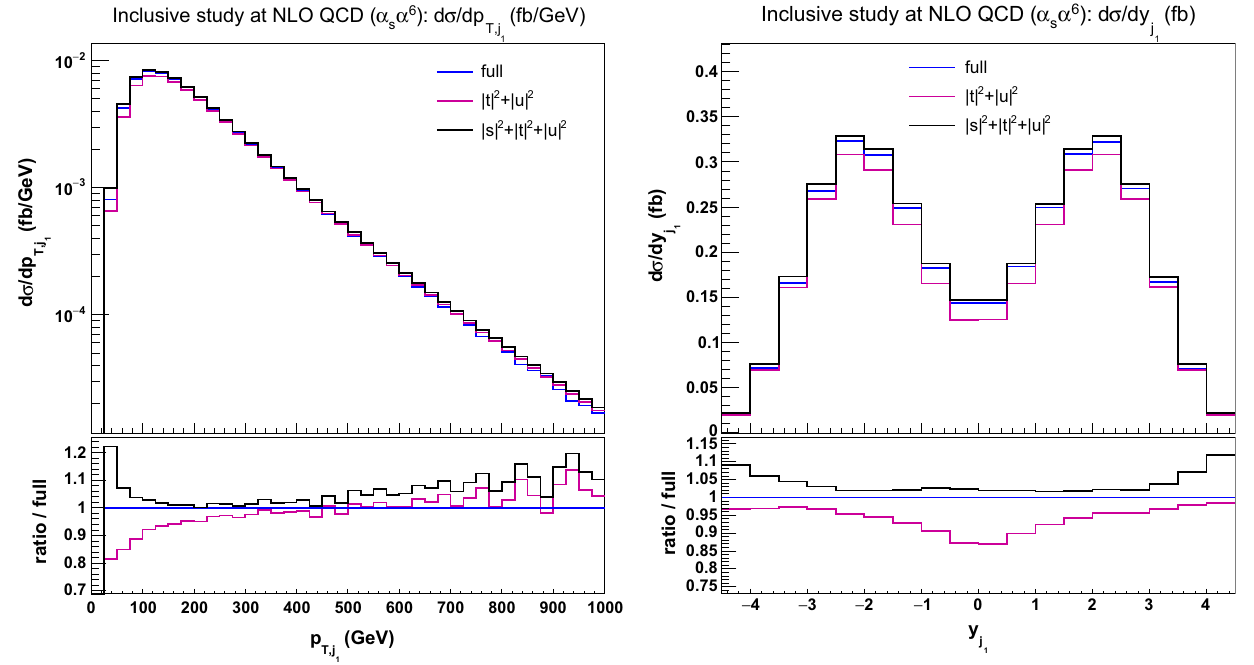
Fig. 8 Differential distributions in the transverse momentum (left) and rapidity (right) of the hardest tagging jet at NLO QCD i.e. at order α 6 ) for the full computation and two approximations. The upper O (α s plots provide the absolute value for each prediction while the lower